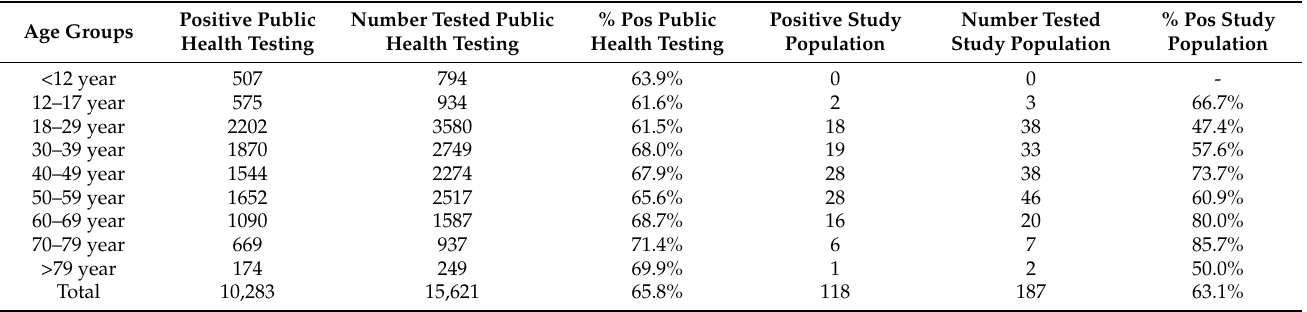
Table 1. Age distribution and percentage SARS-CoV-2 positive of the study population compared to the public health service testing population.